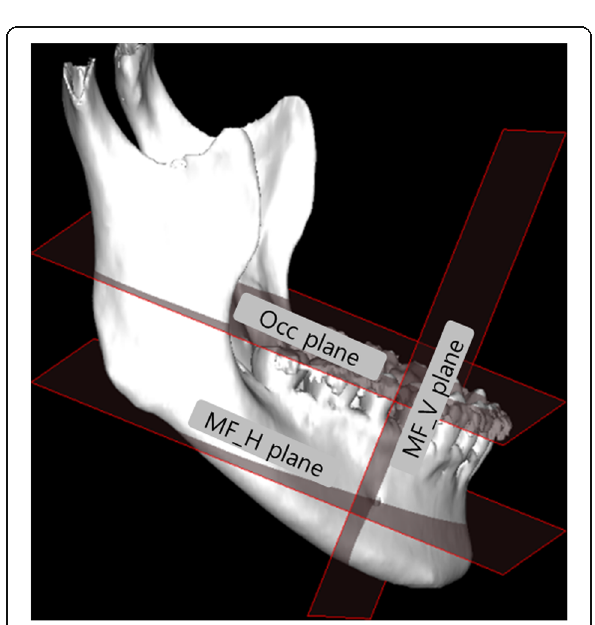
Fig. 2 Occ, MF_V, and MF_H plane. Occ plane, a plane through the bilateral mandibular first molar mesiobuccal cusp and the center of the lower incisal edge; MF_V plane, a plane through the MF point and parallel to the Occ plane; MF_H plane, a plane through the bilateral MF point and perpendicular to the Occ